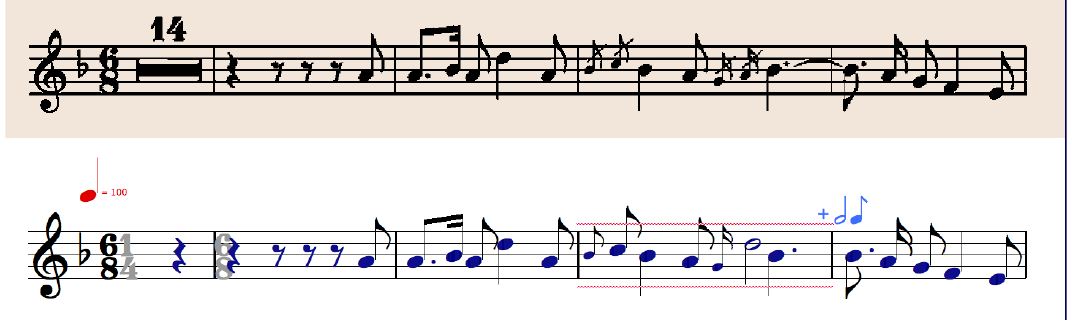
Figure 10. Incipit RISM ID no. 000101138. Se al labbro mio non credi . Giovanni Battista Pergolesi. Photoscore fails at recognizing the content, whereas the prediction of our system is exact. ( a ) Photoscore output: Many mistakes are made; ( b ) Output of our system: The sample is perfectly